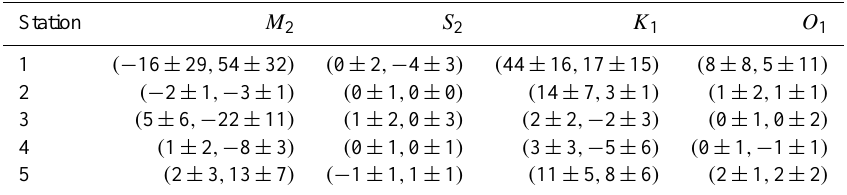
Table 4. Depth-integrated baroclinic fluxes, F , in units of Wm − 1 inferred from STORMTIDE using the grid points within 10km of the observation stations. The average ± 1SD over the corresponding grid points are listed for the horizontal components (F u ,F v ) of the four major